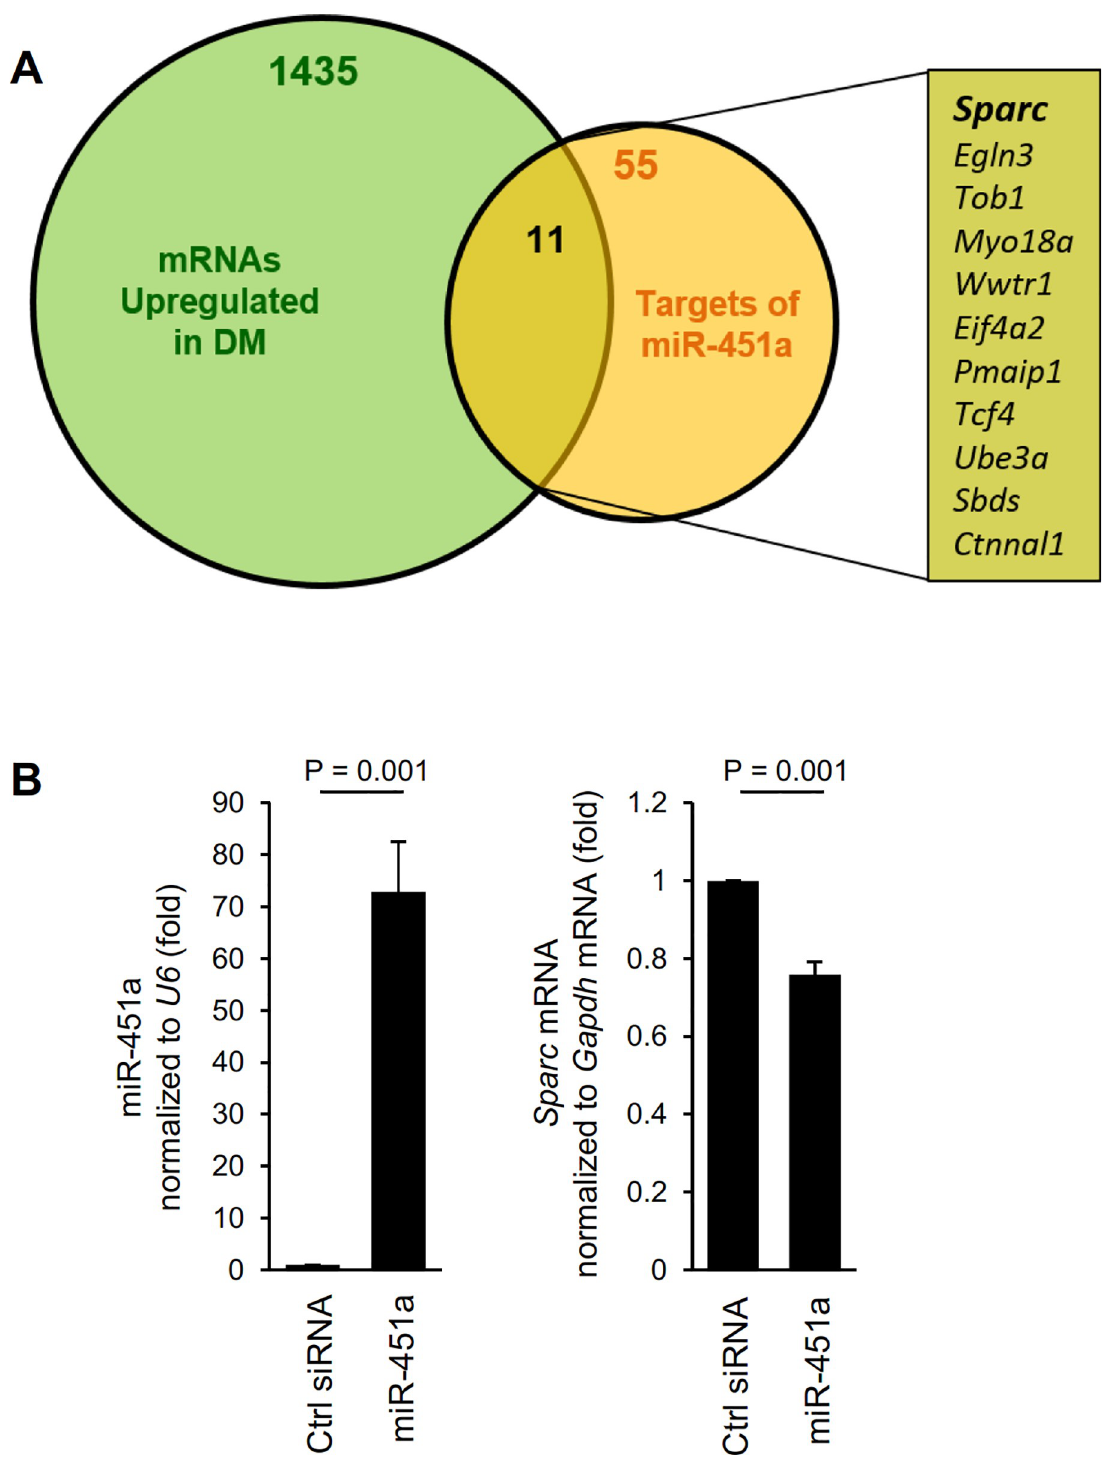
Fig 2. Identification of miR-451a targets in muscle cells. (A) Venn diagram representation of mRNAs upregulated during C2C12 differentiation (green) and experimentally identified target mRNAs of miR-451a (orange) to find miR-451a targets implicated in regulating myogenesis. ( B) RT-qPCR analysis of miR-451a level after overexpression of miR-451a in C2C12 cells ( left ). RT-qPCR analysis of Sparc mRNA induction after overexpression of miR-451a in C2C12 cells ( right ). Data represent the means ± SEM from 3 independent experiments. Significance (P) is